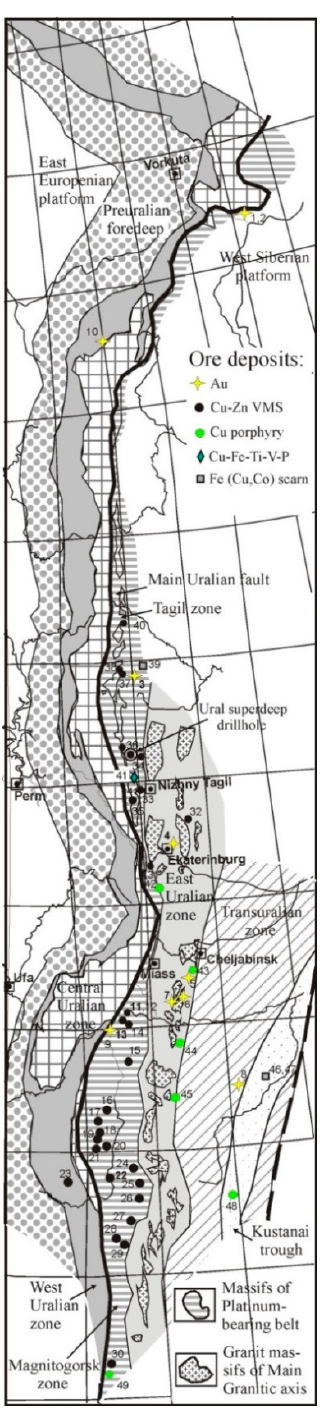
Figure 1. Structural zones of the Urals and the position of Au- and Cu-bearing deposits (on the tectonic base of [61]). Ore deposits: 1 Novogodnee-Monto , 2 Pervopavlovsk , 3 Vorontsovka , 4 Berezovsk , 5 Bereznyakovsk, 6 Kochkar, 7 Svetlinsk, 8 Varvarinskoe, 9 Murtikty, 10 Chudnoe, 11